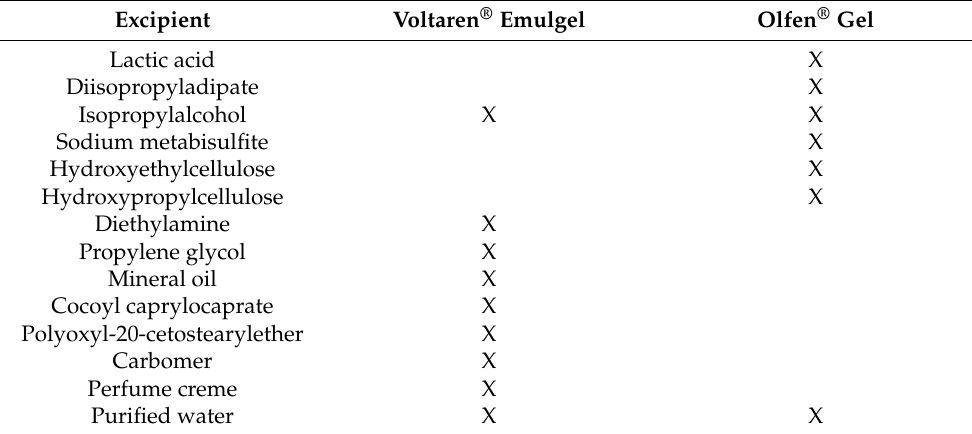
Table 6. List of excipients of Voltaren ® Emulgel and Olfen ®